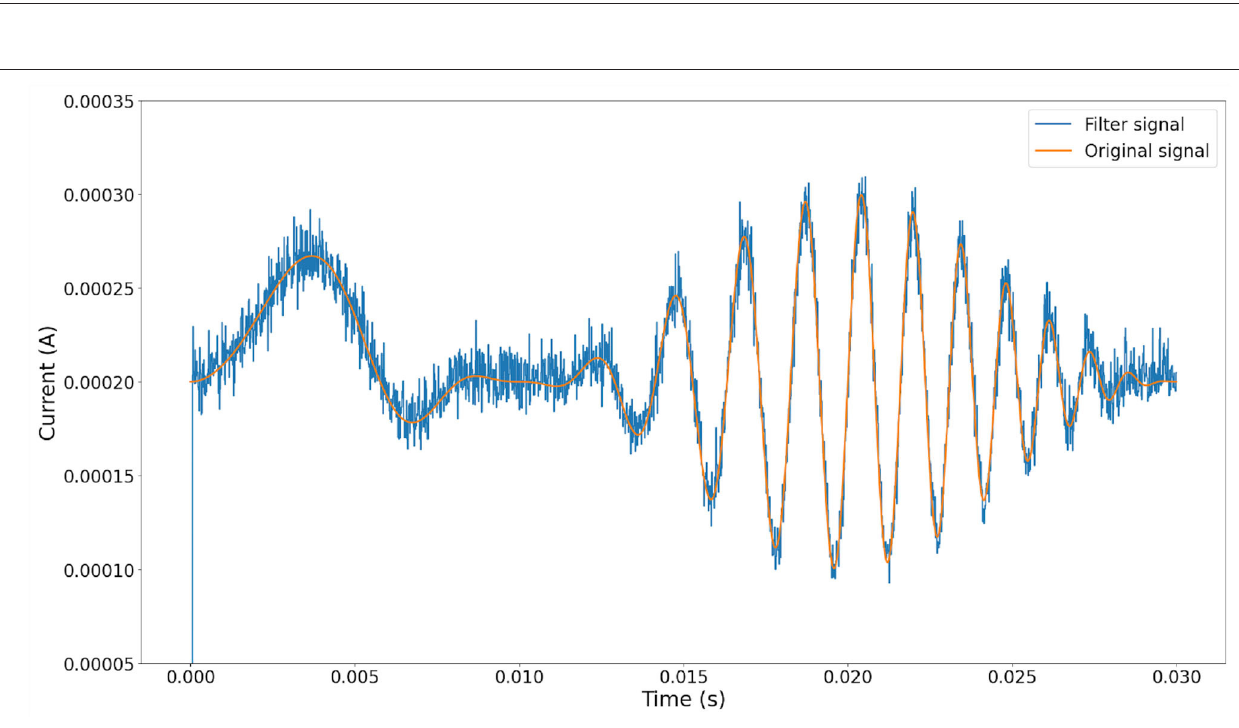
FIGURE 8 | Comparison between signal rebuild from spike frequency on neuron output (blue line) and original signal (orange line).